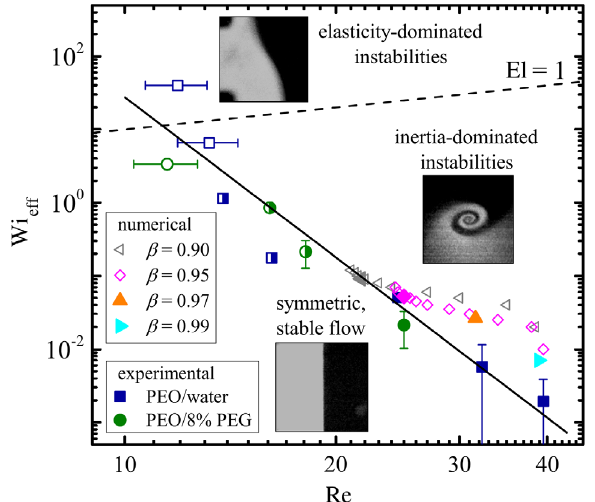
− Re param- FIG. 13. Stability diagram in dimensionless Wi eff eter space. A stable region is indicated below the solid line, drawn through the experimental data as a guide to the eye. For experiments, closed symbols represent steady spiral vortex instabilities, half-closed symbols represent unsteady spiral vortex instabilities, and open symbols represent elasticity-dominated asymmetries. For numerical results, open symbols represent constant Wi , while closed symbols represent constant El eff simulations.